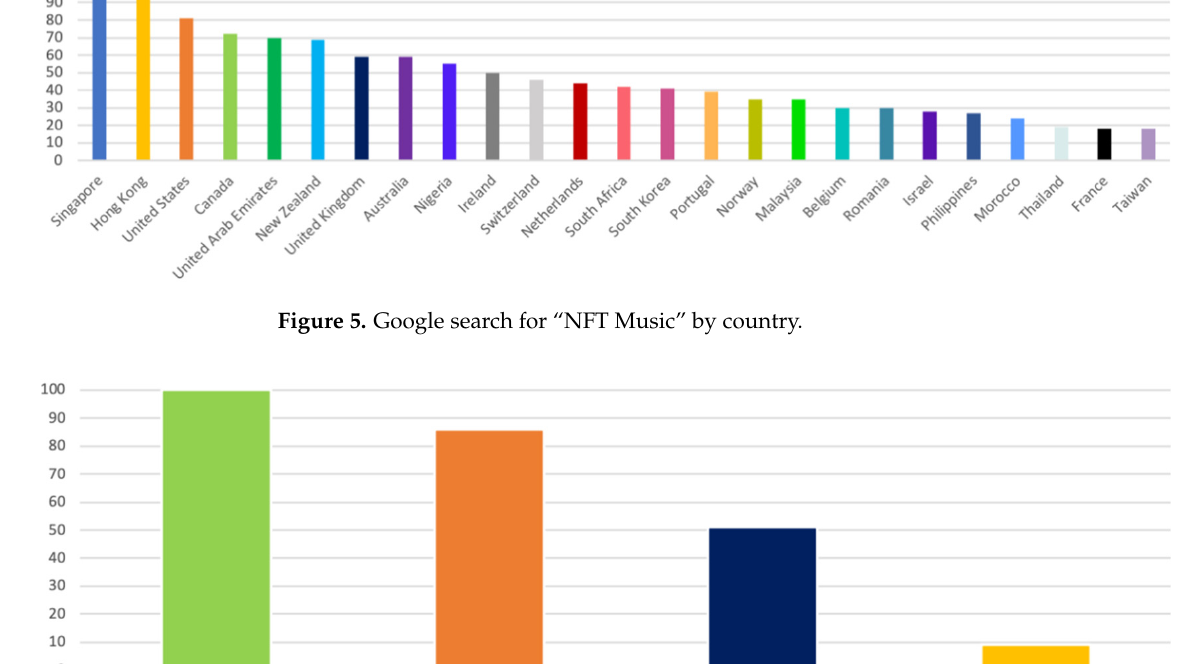
Table 3. NFT marketplaces under analysis.